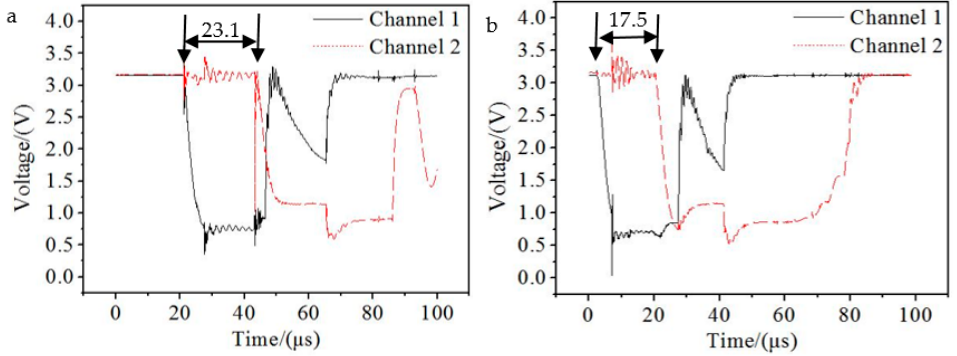
Figure 21. Pulse curve: ( a ) L = 174; ( b ) L = 174.